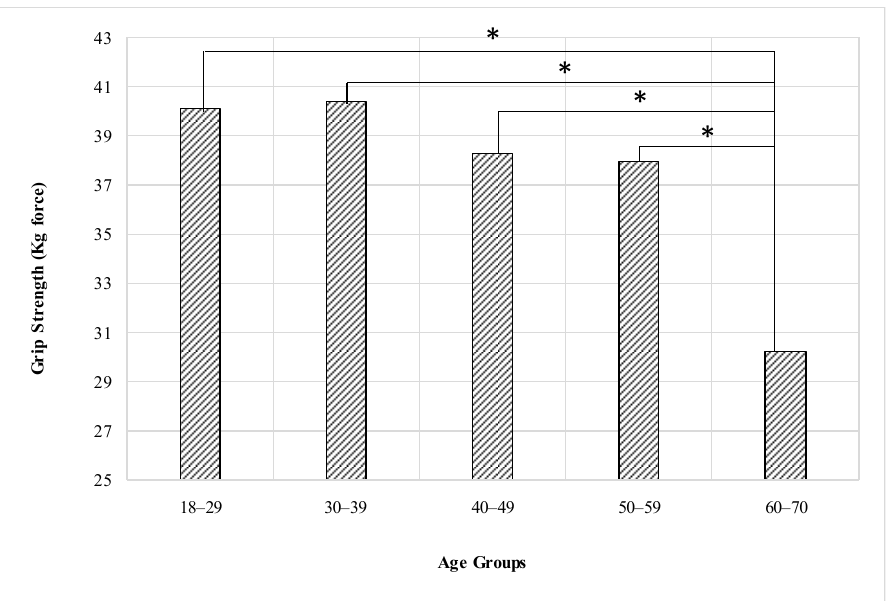
Figure 3. Effect of gender on the grip strength (*means there is a significant difference between levels) .